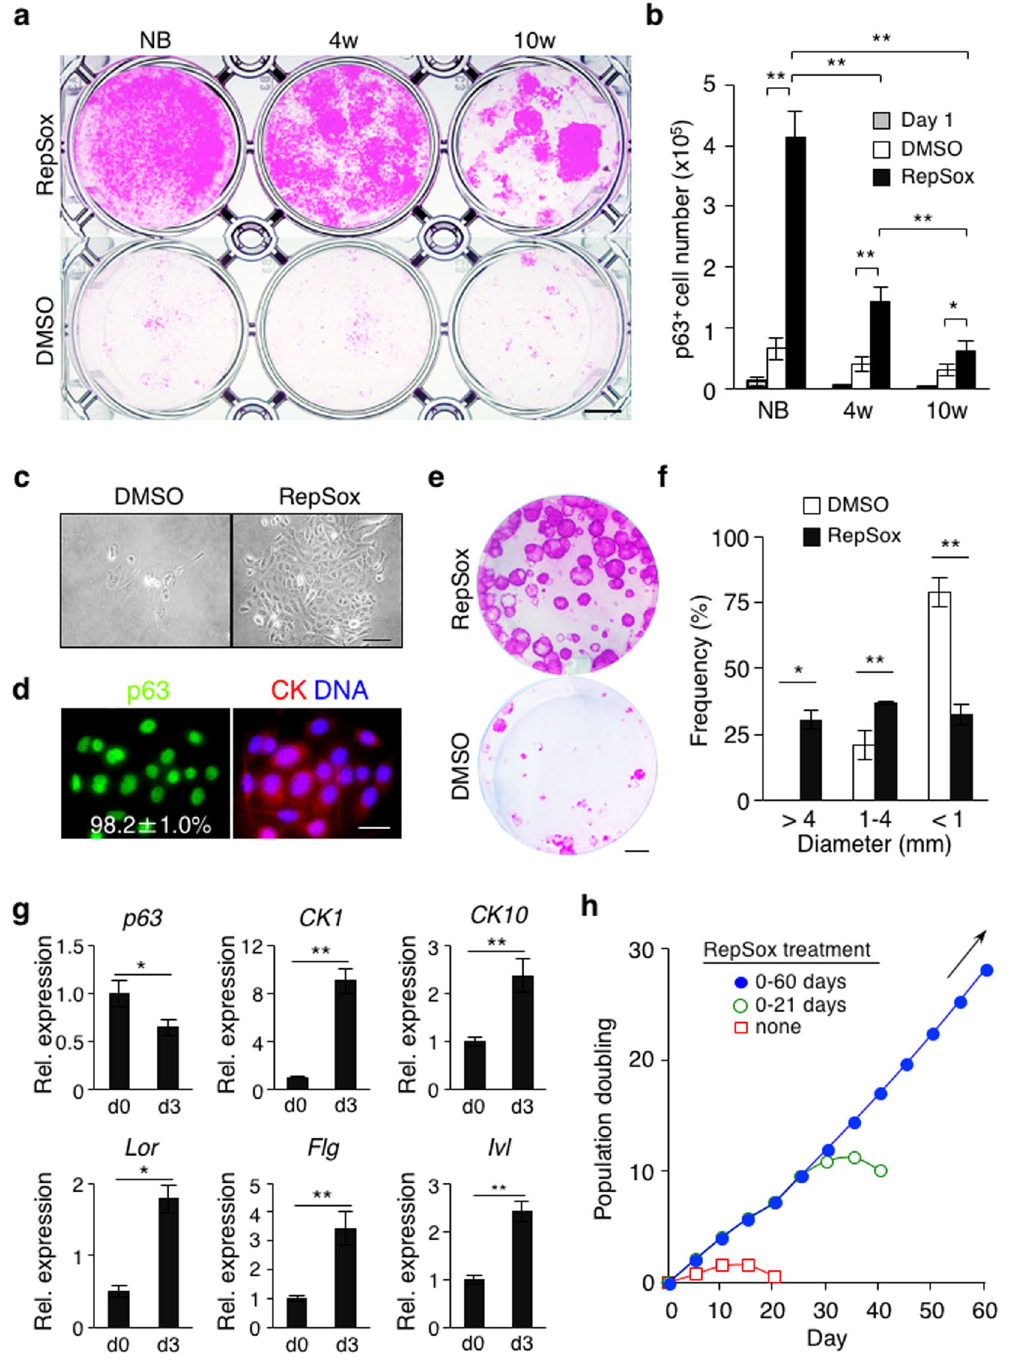
Figure 4. Inhibition of TGF- β signaling supports high proliferative potential of p63 + epidermal progenitor cells of postnatal mice. ( a ) Representative images of Rhodamine B staining of crude culture of epidermal cells harvested from newborn (NB), 4-week-old (4w), and 10-week-old (10w) mice and grown in CnT-PR media in the presence (upper) or absence (lower) of 1 μ M RepSox for 14 days. One million primary cells were seeded. Data shown are representative of two independent experiments with similar results. Bar = 5 mm. ( b ) Total number of p63 + epidermal cells. One million primary cells were seeded and adherent cells were counted at day1 in replicative wells (grey bars) as the majority of the cells remained in suspension. Solid bars and open bars represent total numbers of p63 + epidermal cells at day 14 of culture in the subsequent presence of 1 μ M RepSox or 0.1% DMSO, respectively (n = 3). * P < 0.05; ** P < 0.01. ( c ) Representative images of 4-week-old mouse-derived P1 epidermal cells, grown in the presence (right) or absence (left) of 1 μ M RepSox for 6 days. Bar = 50 μ m. ( d ) Representative immunofluorescence images of 4-week-old mouse-derived, RepSox-expanded P1 epidermal cells stained with anti-p63 and anti-pan-CK antibodies and counterstained with Hoechst 33342 (DNA). The number shown in the left panel represents percentages of p63 + cells per field, expressed